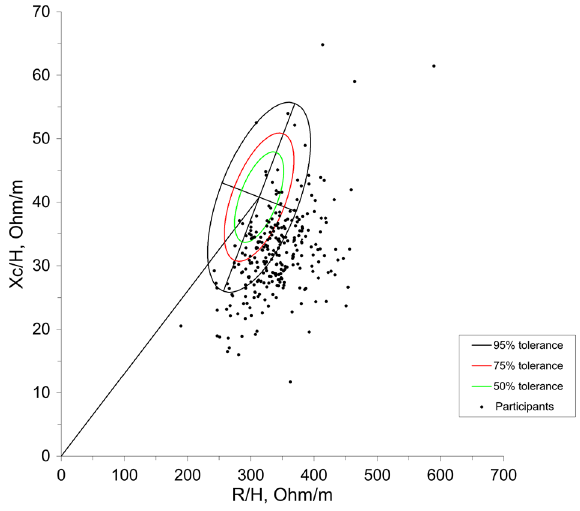
Figure 1. BIVA RXc z-score graph for participants with prostate cancer. Quadrants represent ( i ) top left: high cell mass, ( ii ) bottom right: low cell muscle mass; ( iii ) bottom left: edema, ( iv ) top right: